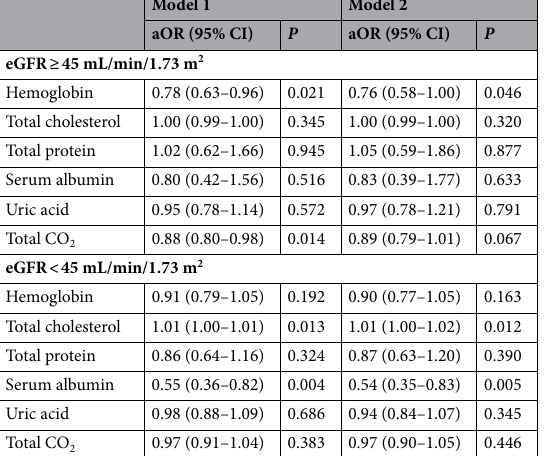
Table 4. The association between biochemical factors and sarcopenia. Model 1: adjusted for sex, age, body mass index, pulse pressure, and estimated GFR. Model 2: adjusted for diabetes mellitus and hypertension in addition to Model 1. CI, confidence interval; GFR, glomerular filtration rate; OR, odds